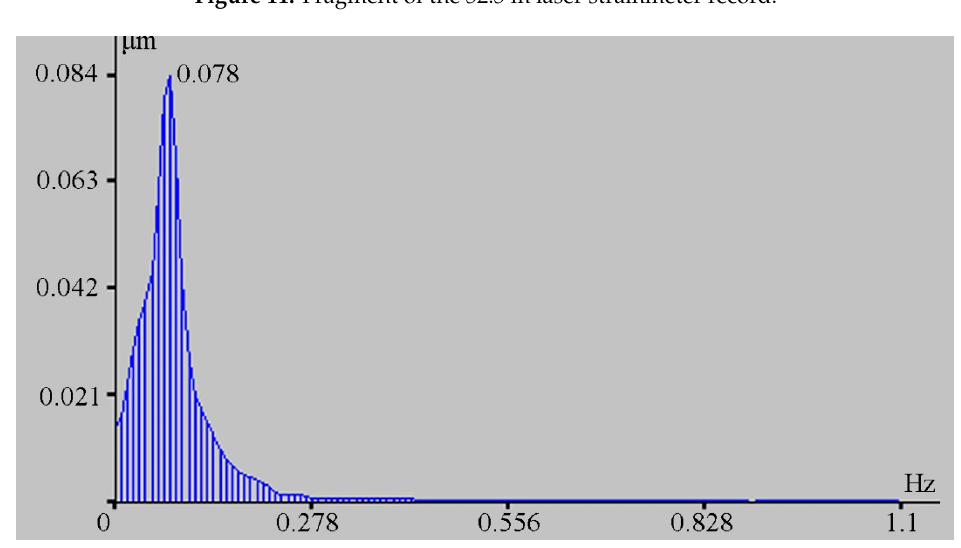
Figure 11. Fragment of the 52.5 m laser strainmeter record.